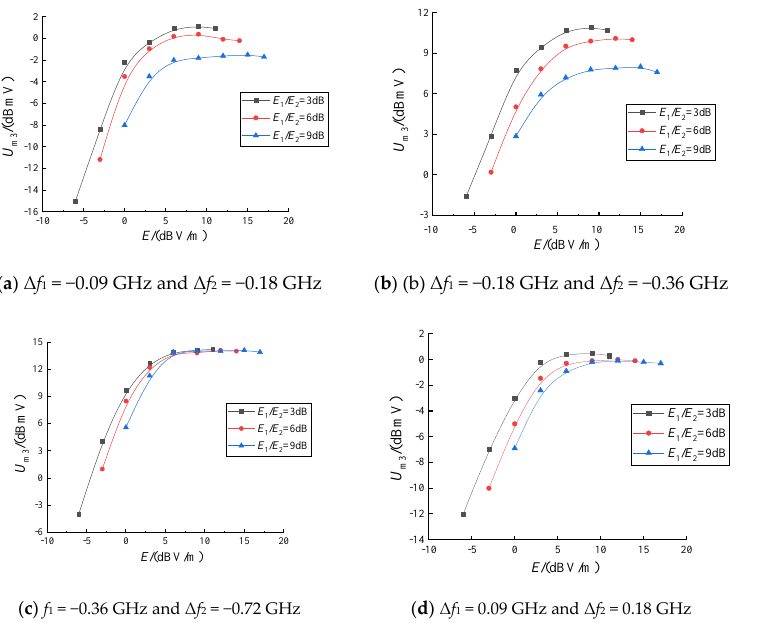
Figure 4. Variation of the four groups of the IMFA − 3 levels with the interference field strength.